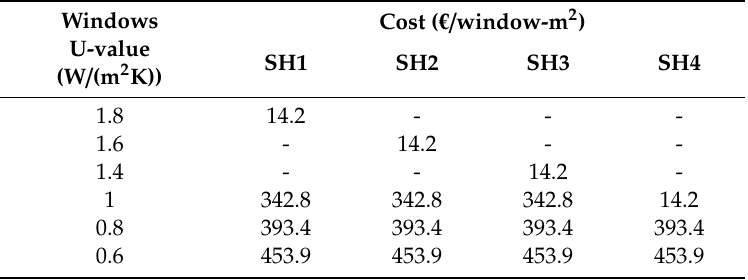
Table 5. Cost of a basic refurbishment of current windows or replacing them with new ones.